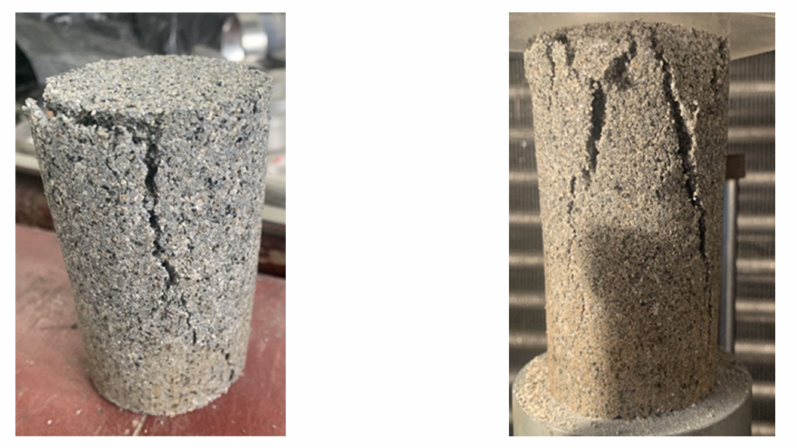
Figure 3. Samples after UCS test for ( a ) without wet–dry cycles and ( b ) with wet–dry cycles.